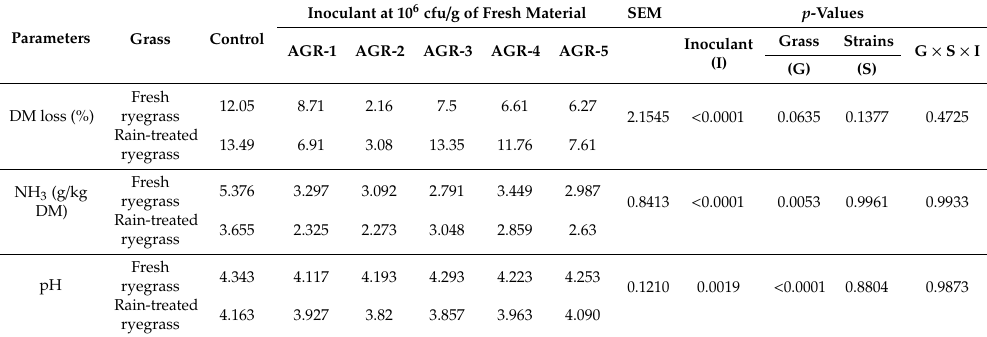
Table 2. E ff ect of LAB strains on dry matter losing, ammonia concentration and pH over 60 days of